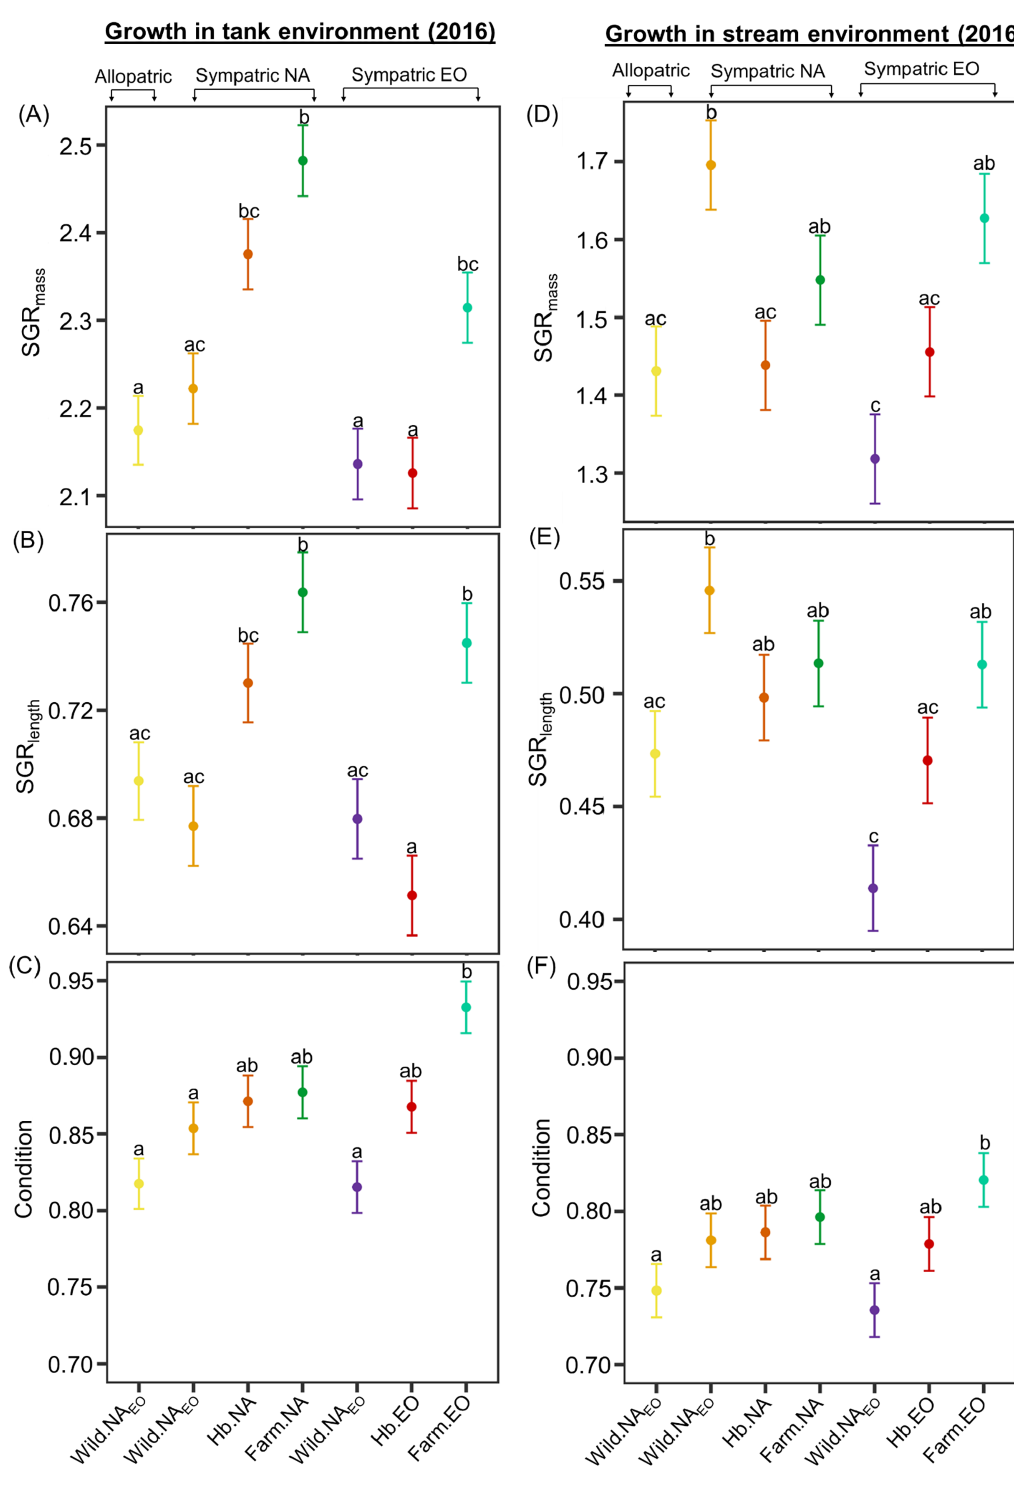
Fig. 3. (A−F) Cross type effects on Atlantic salmon growth differences in tank and stream environments (2016) using mixed- effects models. Displayed are marginal means ±SE. Different letters denote significant differences in estimated marginal mean traits among cross types. The axes differ between panels for specific growth rates in terms of mass (SGR mass ) and length (SGR length ). See Table S2 for estimated marginal means and Table S3 for Tukey-adjusted pairwise contrasts among cross types fitted in the final models. See Fig. 2 for cross